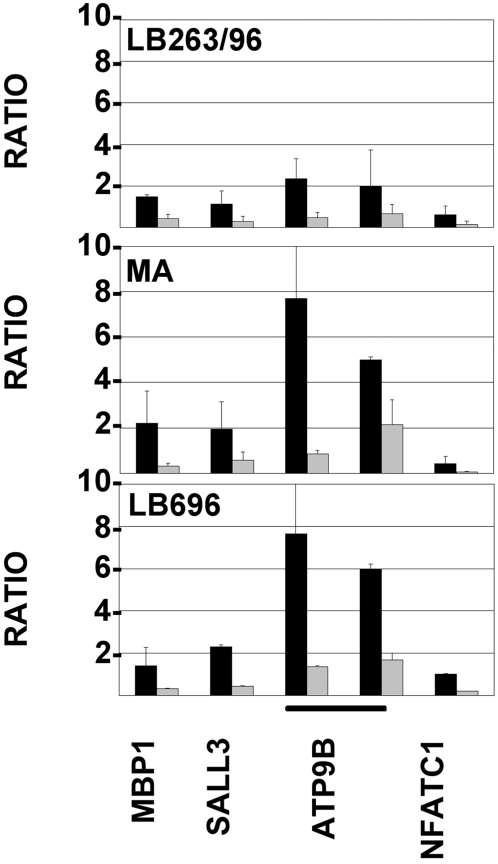
Chromatin modifications of genes flanking the 18q breakpoint, in the LB263/96 patient.Chromatin of the patient 263/96 and two normal lymphoblastoid cell lines was IP with antibodies to acH3, acH4 or to 2MK4H3 and the DNA was amplified by real time PCR with primers in the promoter regions of each gene. One or two sets of primers were utilized for each gene, as indicated. Modifications were calculated as described in Materials and Methods. In the figure, the ratio between acH3/acH4 (black) and acH4/2MK4 (gray) in chromatin from the LB263/96 patient and two normal controls (MA and LB696) is shown.